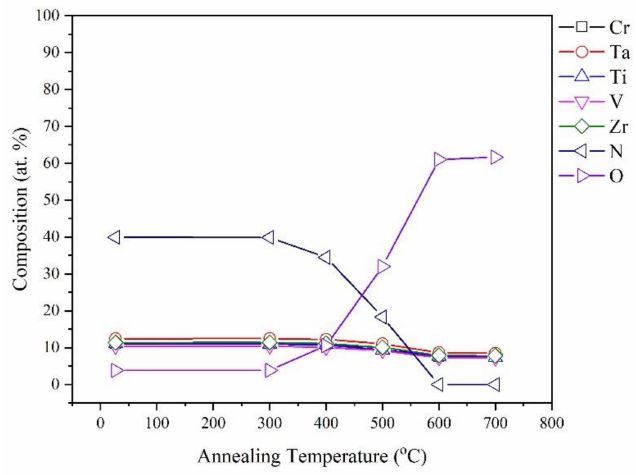
Figure 1. FE-EPMA results of (CrTaTiVZr)N after annealing at di ff erent temperatures in